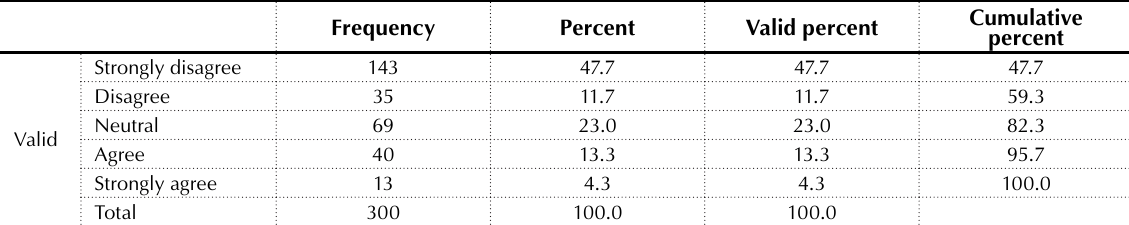
Table 3. Service delivery or awareness campaigns have had a positive impact on views of